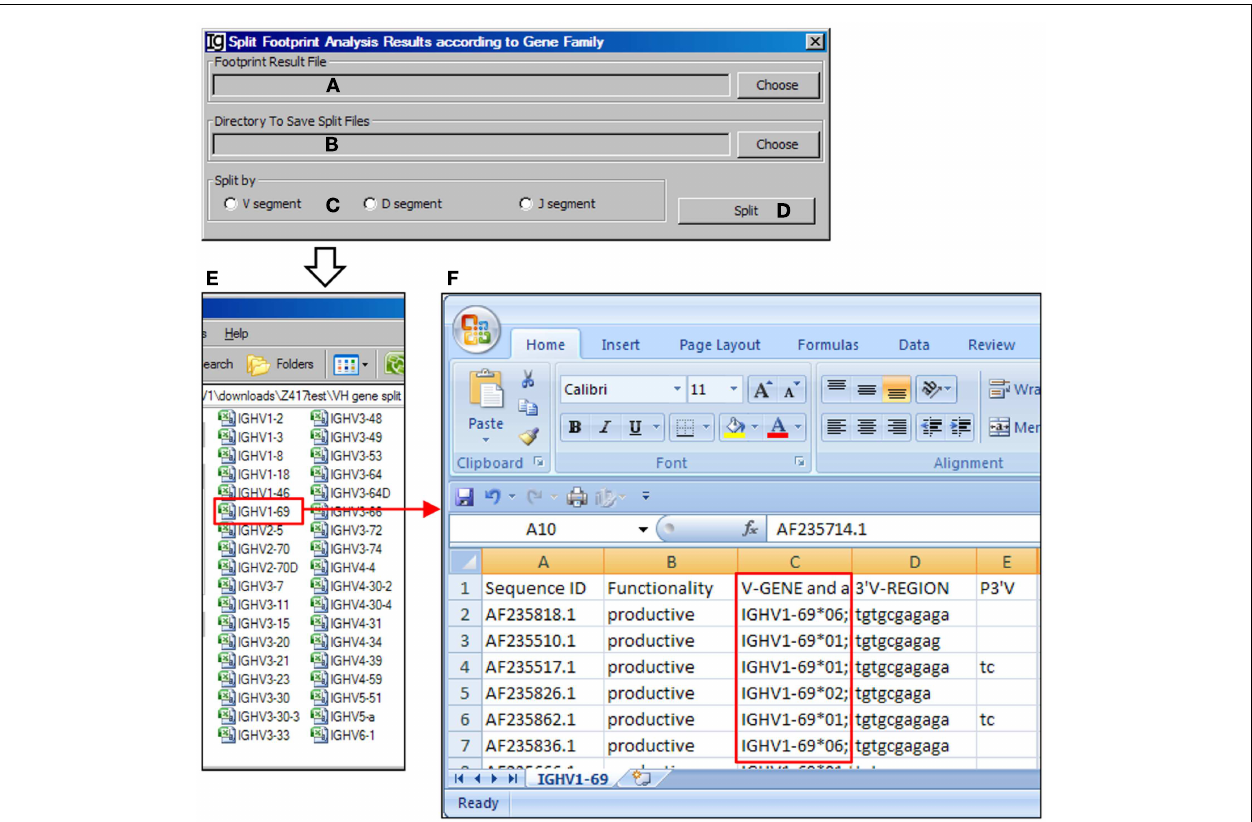
(D) Button to start the splitting process. (E) The split results according to individualV H germline gene are deposited at a user specified location. (F) The example ofV H replacement footprint analysis results of IgH genes using the V H1–69 gene (highlighted in red box